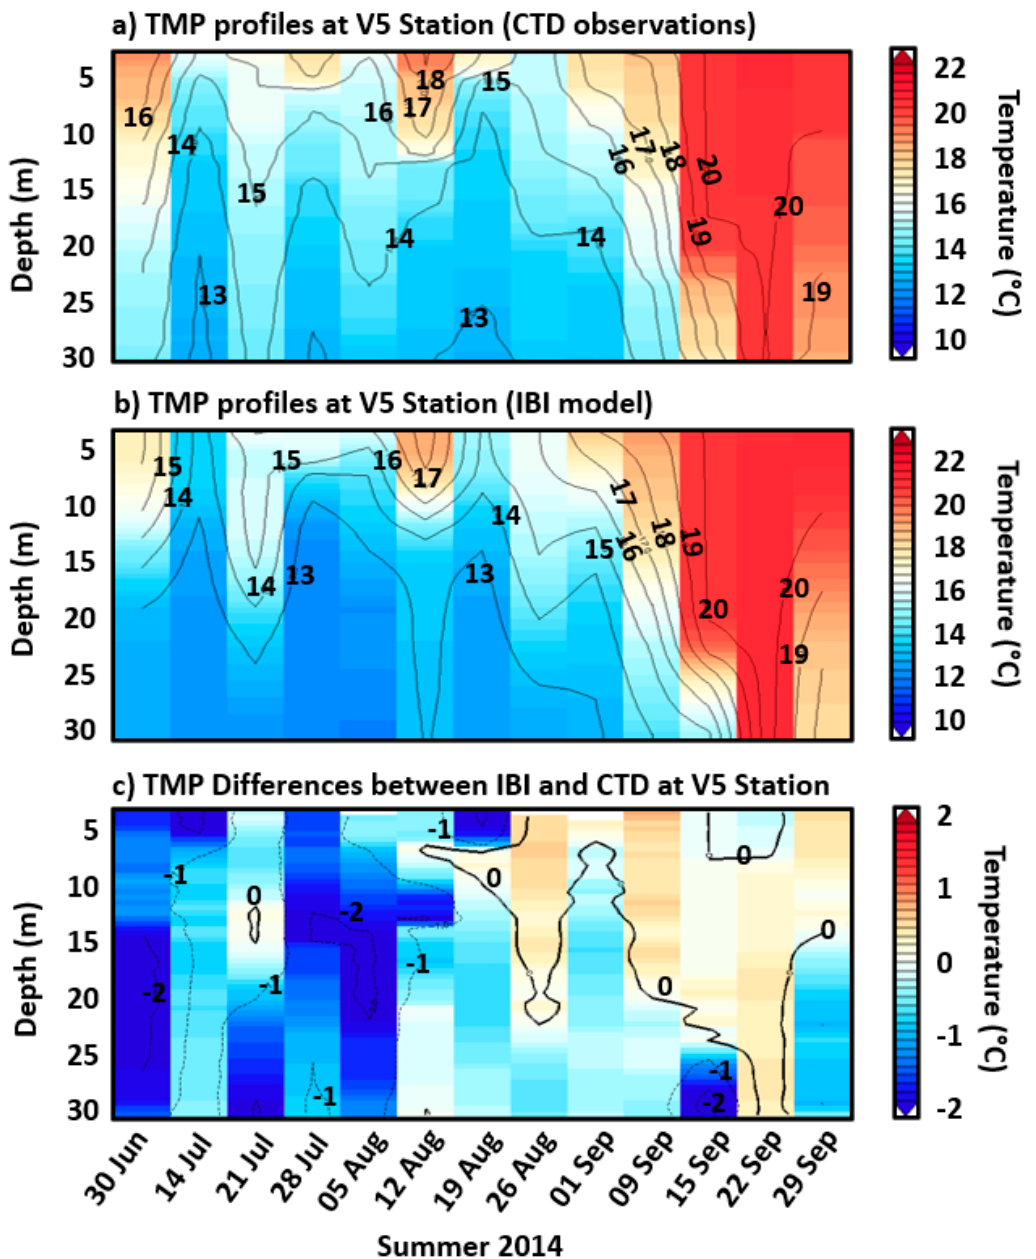
Figure 9. Comparison of temperature (TMP) profiles registered at V5 station (denoted in Figure 1b) by a CDT device ( a ) and IBI model ( b ) at the closest grid point. ( c ) Differences of TMP between the modelled and the observed profiles. Note that this figure is not a Hovmöller diagram but a temporal concatenation of specific dates: Only those CTD in situ observations that successfully fulfilled the quality control have been depicted.